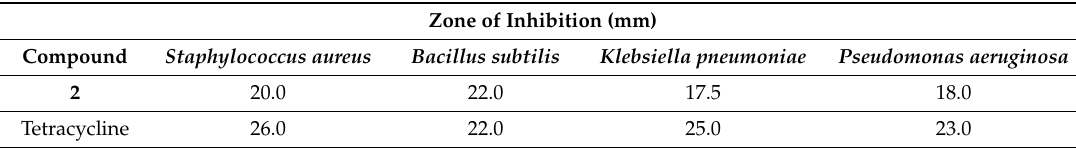
Table 3. Result of antibacterial activity for compound 2 with respect to the standard (Disc diffusion method).